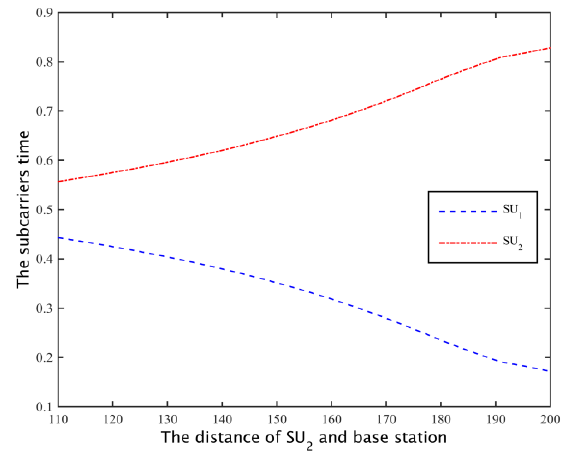
Figure 15. The optimal time assign of secondary users.